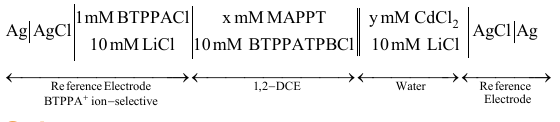
Scheme 1. Schematic representation of the electrochemical cell 1